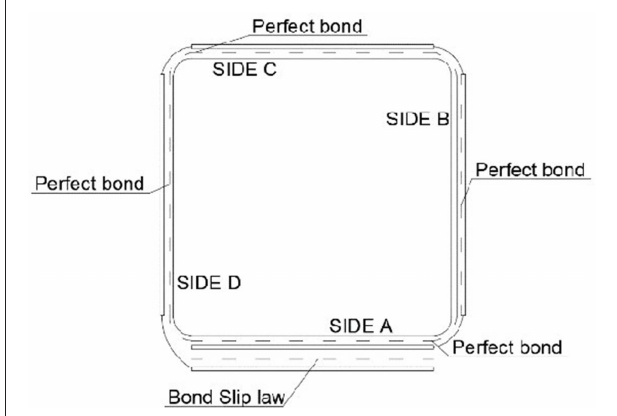
FIGURE 4 | Scheme of interaction between the external reinforcement and masonry columns substrate.